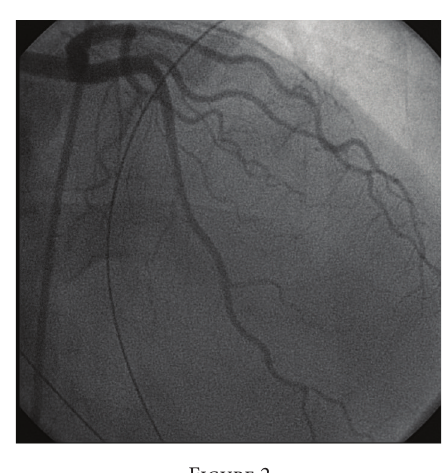
intervention and revascularization. However, in cases where patients do not present with typical chest pain, other diag- nostic tools such as serial cardiac markers and imaging modalities can help elucidate other causes of ECG findings suggesting acute myocardial infarct. A number of disease presentations may mimic ST-elevation myocardial infarction on ECG [1]. Namely, the most common causes are acute pericarditis, myocarditis, coronary spasm, traumatic brain injury, acute aortic dissection, and ventricular aneurysm. Few cases of intra-abdominal pathology causing ST- elevation on ECG have been reported. These conditions have been related to pancreas and gallbladder disease [2–4], esophageal pathology [5–9], splenic rupture [10], and hiatal hernia [11]. To date, our case may be the first reported case of small bowel obstruction as a cause for significant ST- elevation on electrocardiogram mimicking acute myocardial infarction. In our case, the patient developed inferolateral ST- segment elevation on a 12-lead ECG which resolved rapidly after surgical decompression of intestinal distension. It is believed that the intra-abdominal distension resulted in the compression of the diaphragmatic surface of the heart and led to the subsequent ECG